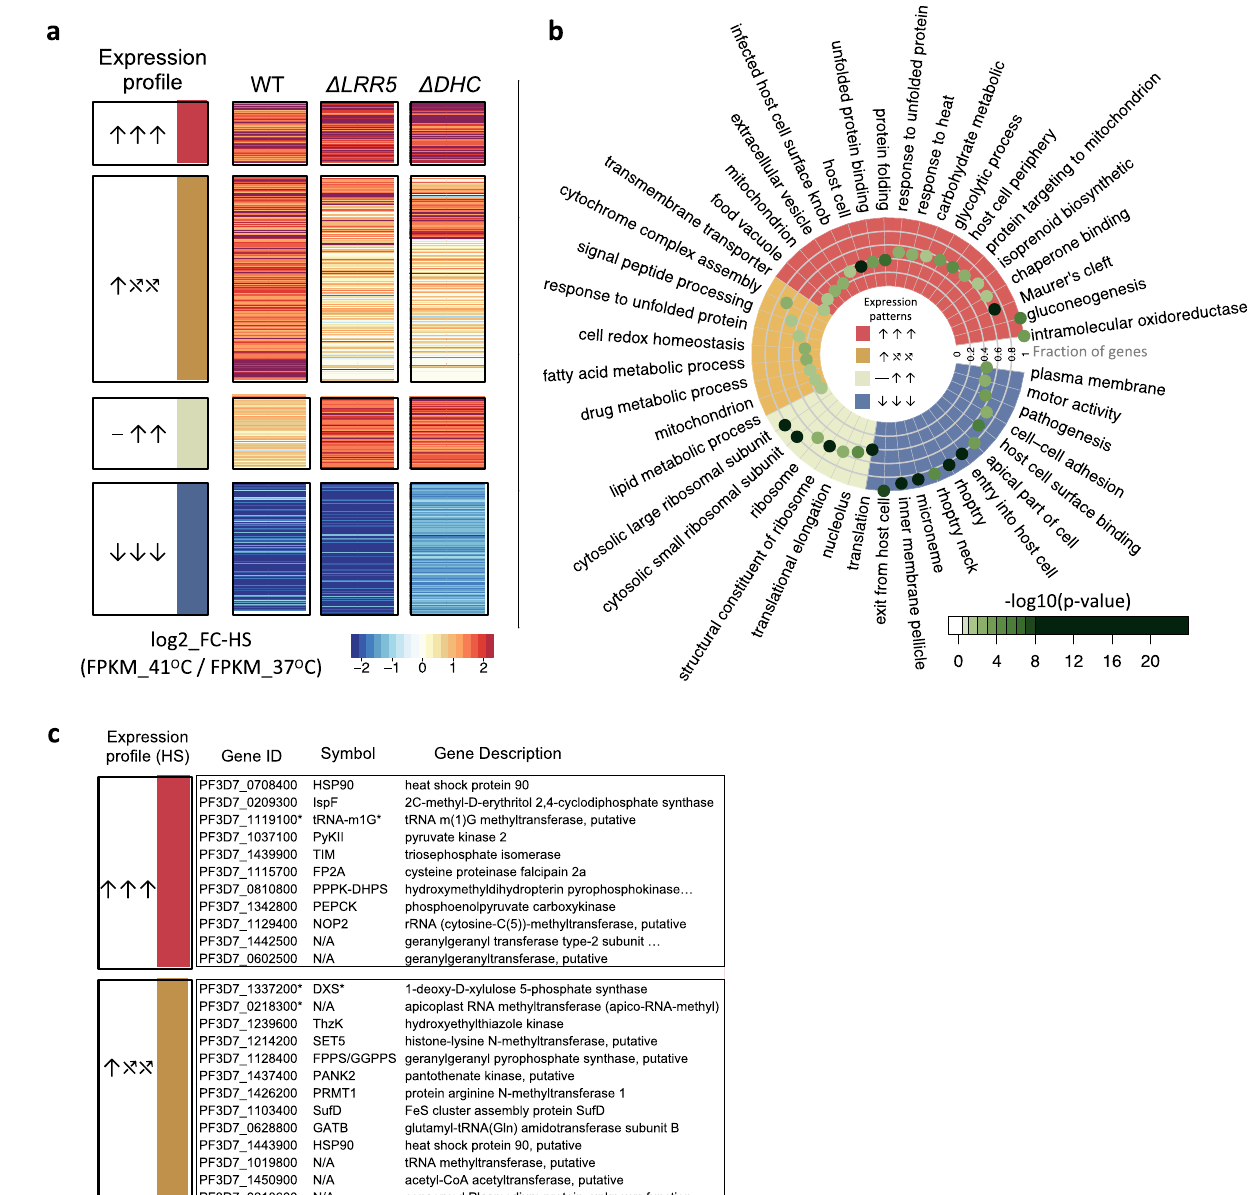
Fig. 3 Unfolded-protein response, apicoplast-targeted, and mitochondria-targeted stress-response pathways are critically dysregulated in functionally unrelated HS-Sensitive mutant clones. a Genes were classi fi ed into three different categories based on NF54-expression with and without HS-exposure across all three parasite lines (Supplementary Data File 3, “ Methods ” section): upregulated in HS ( ↑ , n = 415), downregulated in HS ( ↓ , n = 611), or not regulated by HS ( ⎯ , n = 1541). Genes expressed above threshold in NF54 and both HS-Sensitive mutants ( n = 1298) were then assigned into six HS expression categories based on phenotype in NF54 vs. mutants Δ LRR5 and Δ DHC . HS-regulated genes shared between NF54 and both mutants are indicated in red ( ↑↑↑ , n = 94) or blue ( ↓↓↓ , n = 205) for upregulated and downregulated genes, respectively. Genes dysregulated in one or both HS- Sensitive mutants fell into two main expression-pro fi le categories: those upregulated in NF54 that failed to be regulated in the mutants ( ↑ ⤯⤯ , n = 83), and genes not regulated in response to HS in NF54 that were inappropriately upregulated in the mutants ( ⎯ ↑↑ , n = 74). Most remaining genes were not regulated in response to HS in any parasite line ( n = 615). b Functional enrichment analyses between wild-type/mutant HS-expression pro fi les. Red: Shared upregulated HS-responsive GO-terms between NF54 and the two HS-Sensitive pB -mutants ( ↑↑↑ ). Blue: Shared downregulated GO-terms ( ↓↓↓ ). Ocher: GO-terms upregulated in NF54 but dysregulated in both mutants ( ↑ ⤯⤯ ). Tan: GO-terms enriched in genes not regulated in the wild-type HS- response but upregulated in the mutants ( ⎯ ↑↑ ). Only enriched GO-terms are shown (two-tailed Fisher/elim-hybrid test p -value ≤ 0.05), with the highest signi fi cance indicated in dark green. Fraction of signi fi cant genes mapping to a GO-term in an HS expression-pro fi le category vs. genes mapping to that GO-term in the entire analysis is indicated by distance to the center of the circle. Source data are provided as a Source Data fi le. c Several apicoplasts and isoprenoid biosynthesis-related genes were upregulated in the wild-type response to HS and were dysregulated in one or both HS-Sensitive pB -mutant clones ( ↑ ⤯⤯ ). *Isoprenoid biosynthesis-related genes upregulated by HS con fi rmed in the pooled HS-Screen.